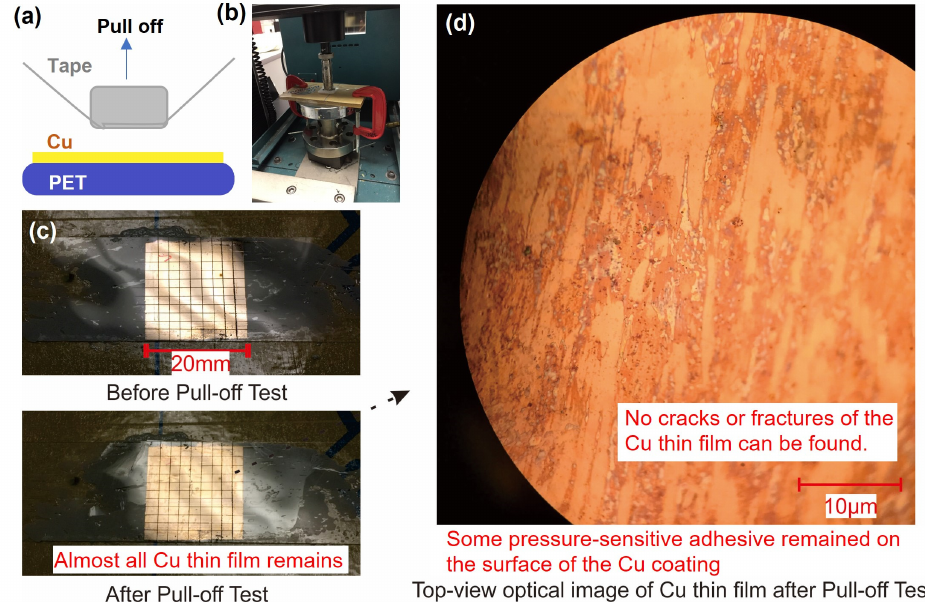
Figure 3. The peel test shows the extent of adhesion between the copper coating and the PET substrate. ( a ) Schematic showing how the peel test was performed. ( b ) Photograph of the setup used in the peel test. ( c ) Optical images showing the copper coating on the PET substrate before ( top ) and after ( bottom ) the peel test. ( d ) A microscopic image showing the surface of the copper coating. We used a ruler and sharp tweezers to make several parallel scratches on the surface of the copper coating to divide the original complete square Cu film into 99 parts. ( d ) A microscopic image showing the surface of the copper coating after the pull-off